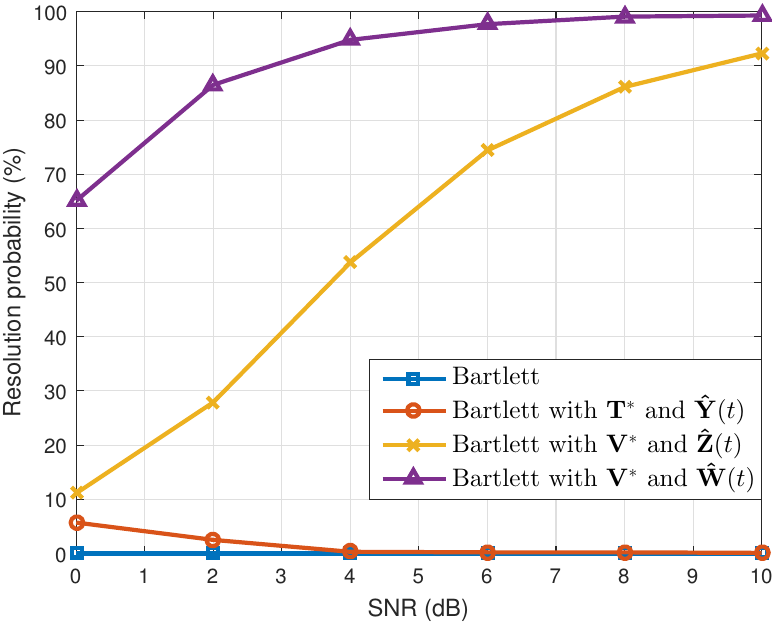
Figure 8. Resolution probabilities versus SNR ( N = 3).